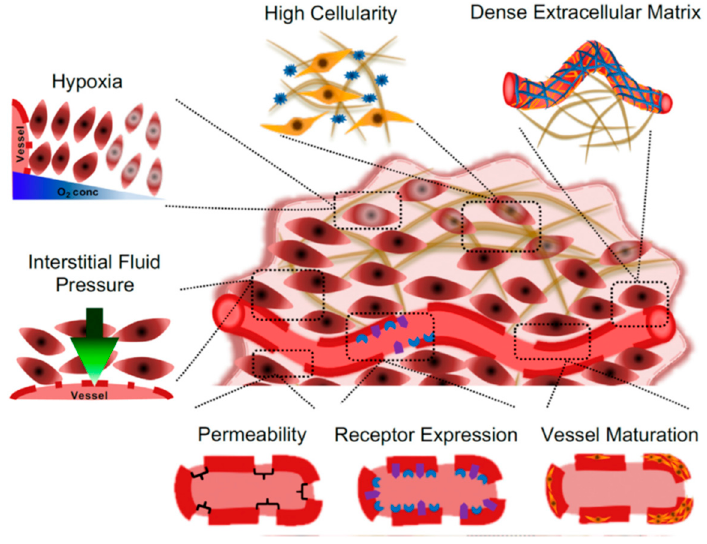
Figure 2. Schematic representation of the architecture of solid tumor vessels. Reproduced with permission from [59]. Copyright (2018) Elsevier.